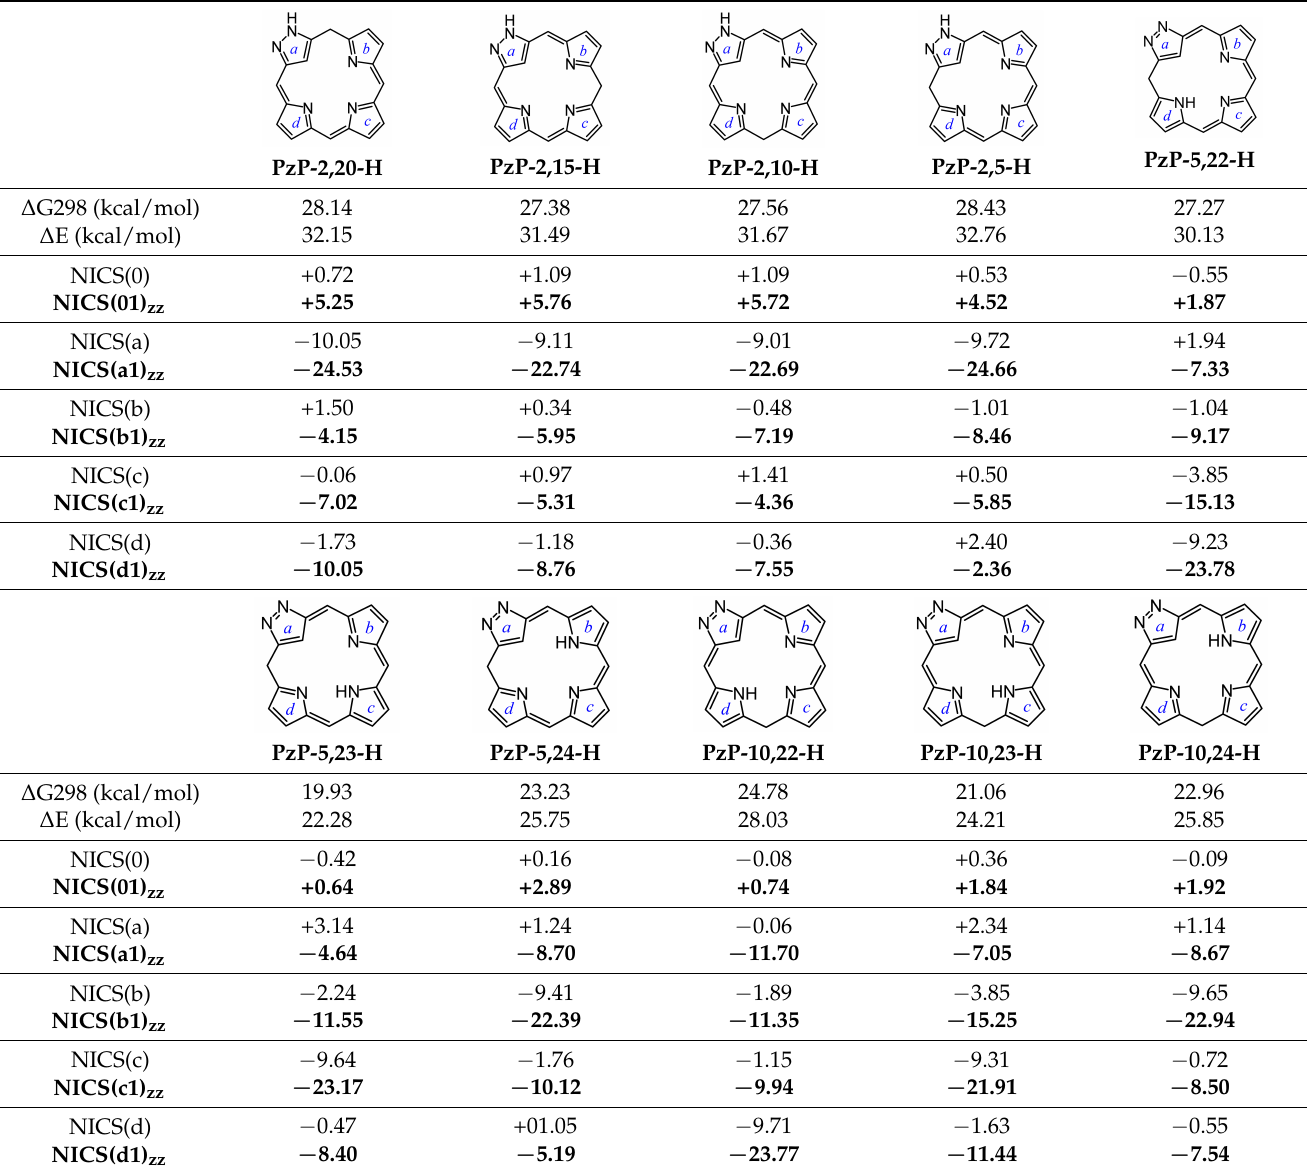
Table 2. Calculated Relative Energies (kcal/mol) and NICS Values (ppm) for Pyrazoloporphyrin Tautomers with Methylene